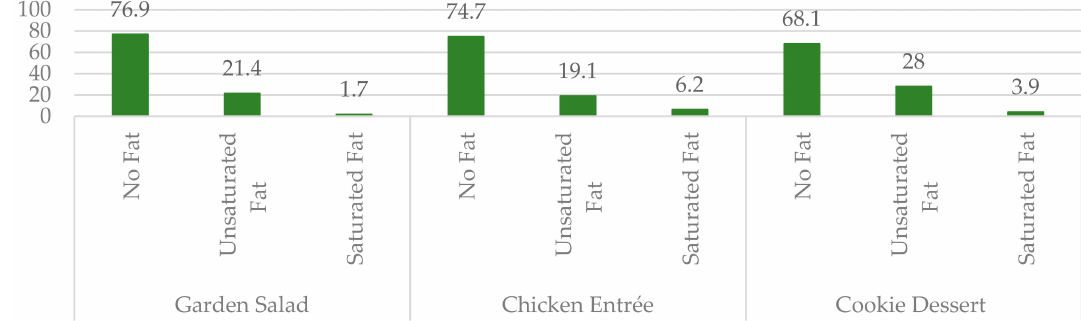
Figure 1. Frequency of fat option choice per meal type in the Faith in Fat study. Across all meal types, the no-fat preparation option was chosen 73% of the